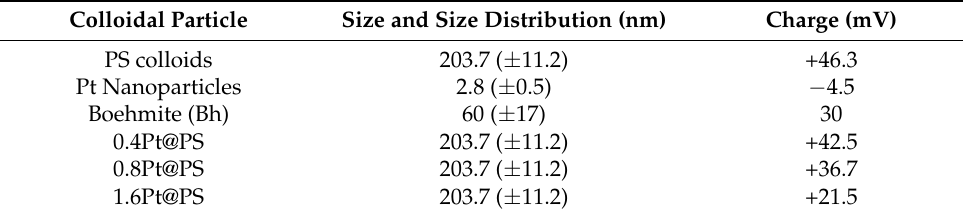
Table 1. Characterization of the building blocks used to synthesize SD